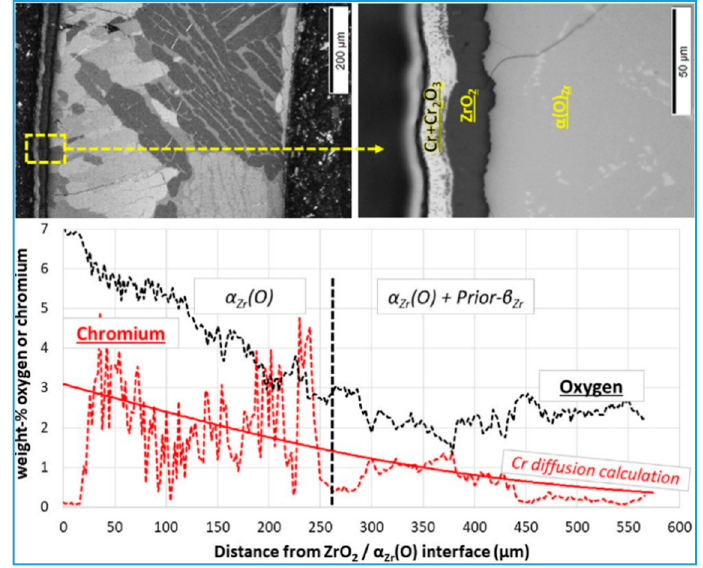
Figure 11. Cr diffusion profiles in the M5 PQ cladding coated with a 12–15 μ m thick Cr layer after the high-temperature steam oxidation at 1200 °C for 9000 s. Reproduced from the work in [35] with copyright permission from